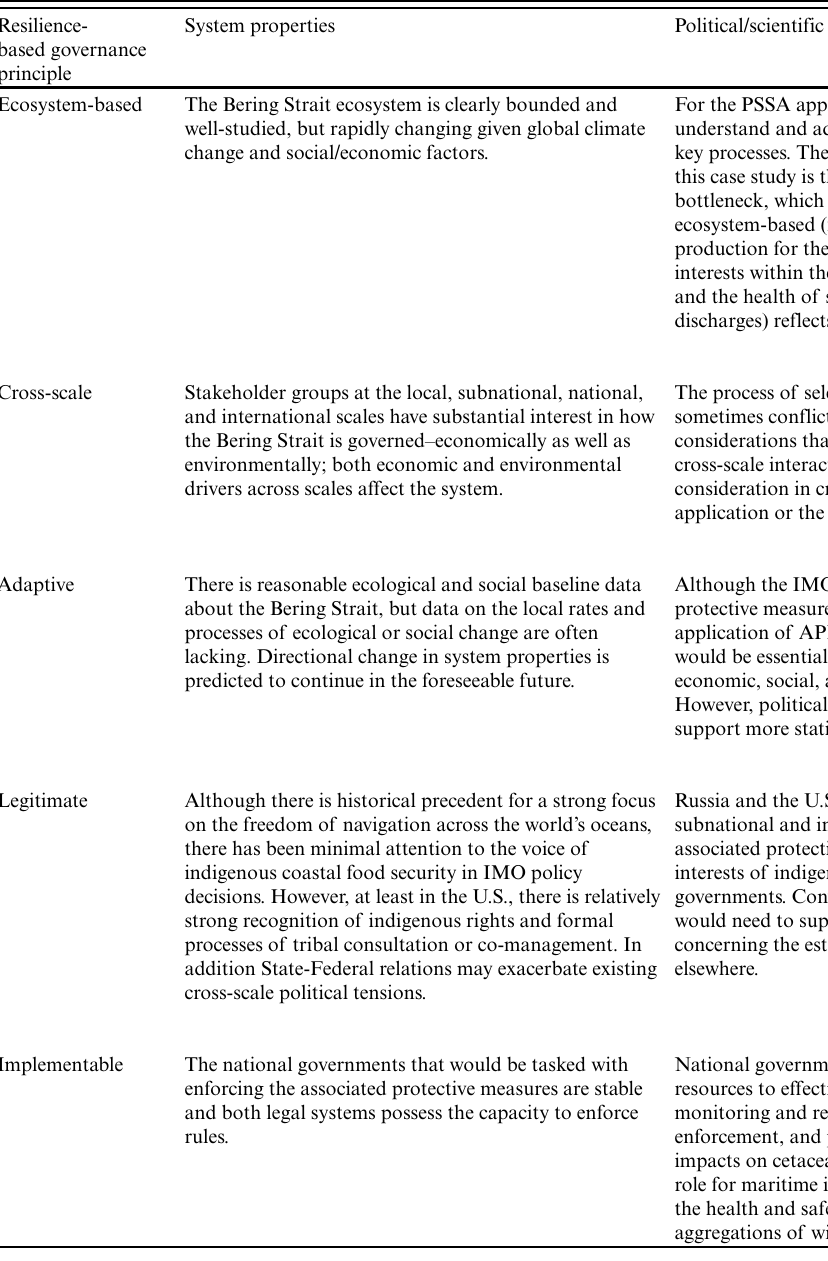
Table 4 . Bering Strait system properties and the related political/scientific decisions that would facilitate the operationalization of resilience-based governance principles through the PSSA